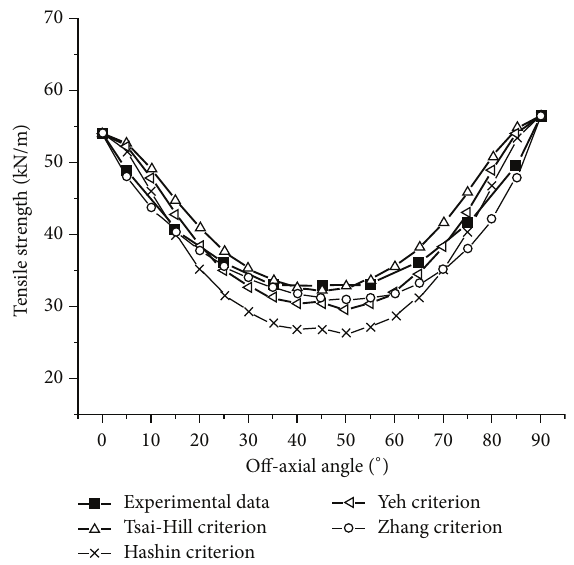
Figure 10: Comparison of experiment data and predictions of several existing strength